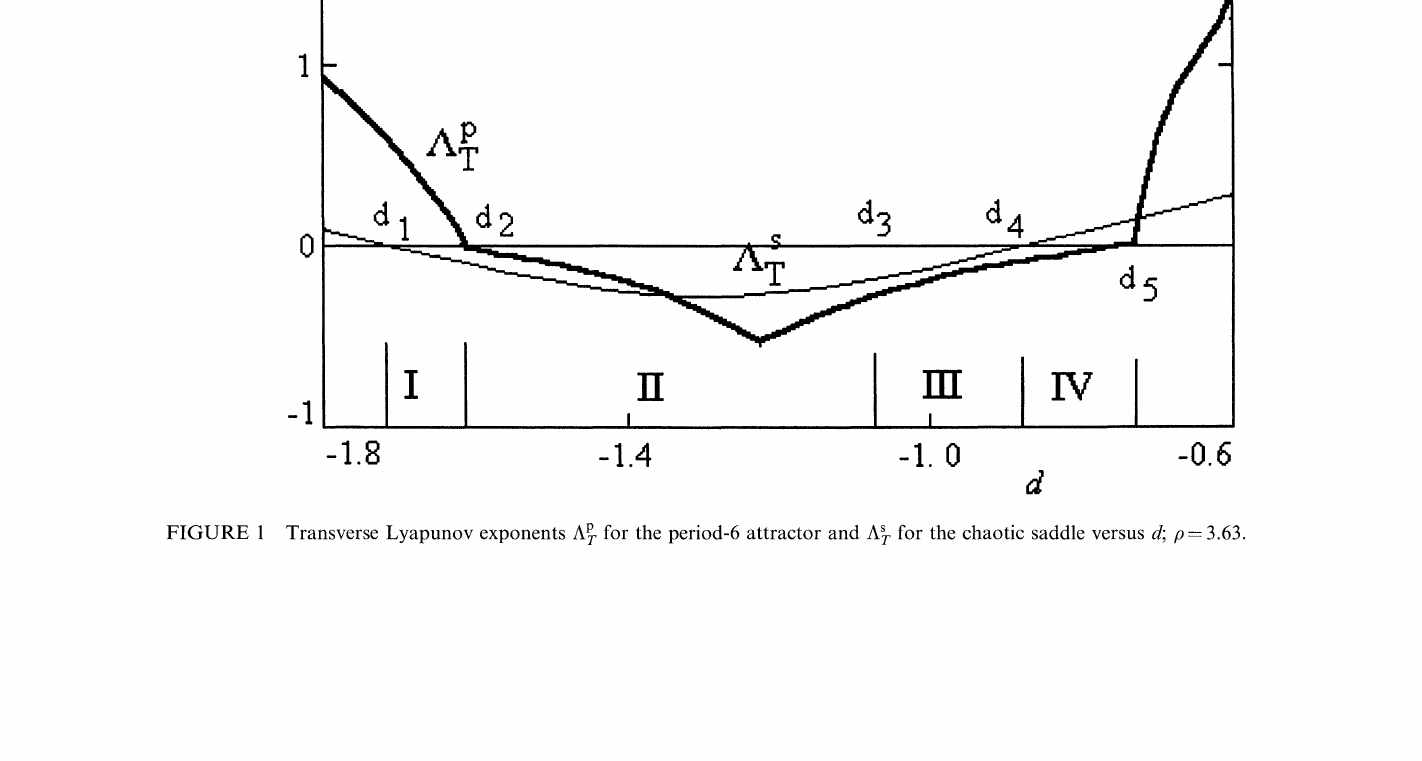
Transverse Lyapunov exponents A for the period-6 attractor and A for the chaotic saddle versus d; p